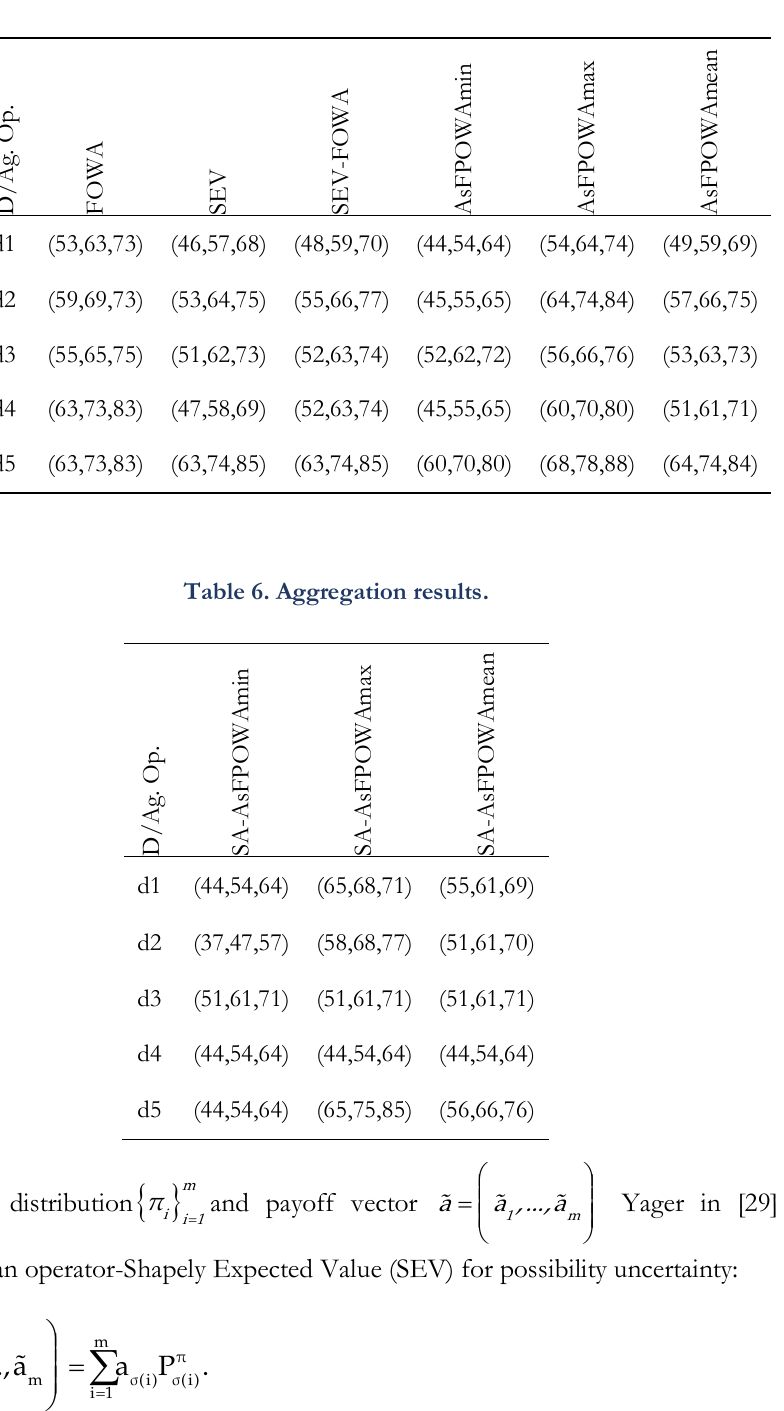
Table 5. Aggregation results.